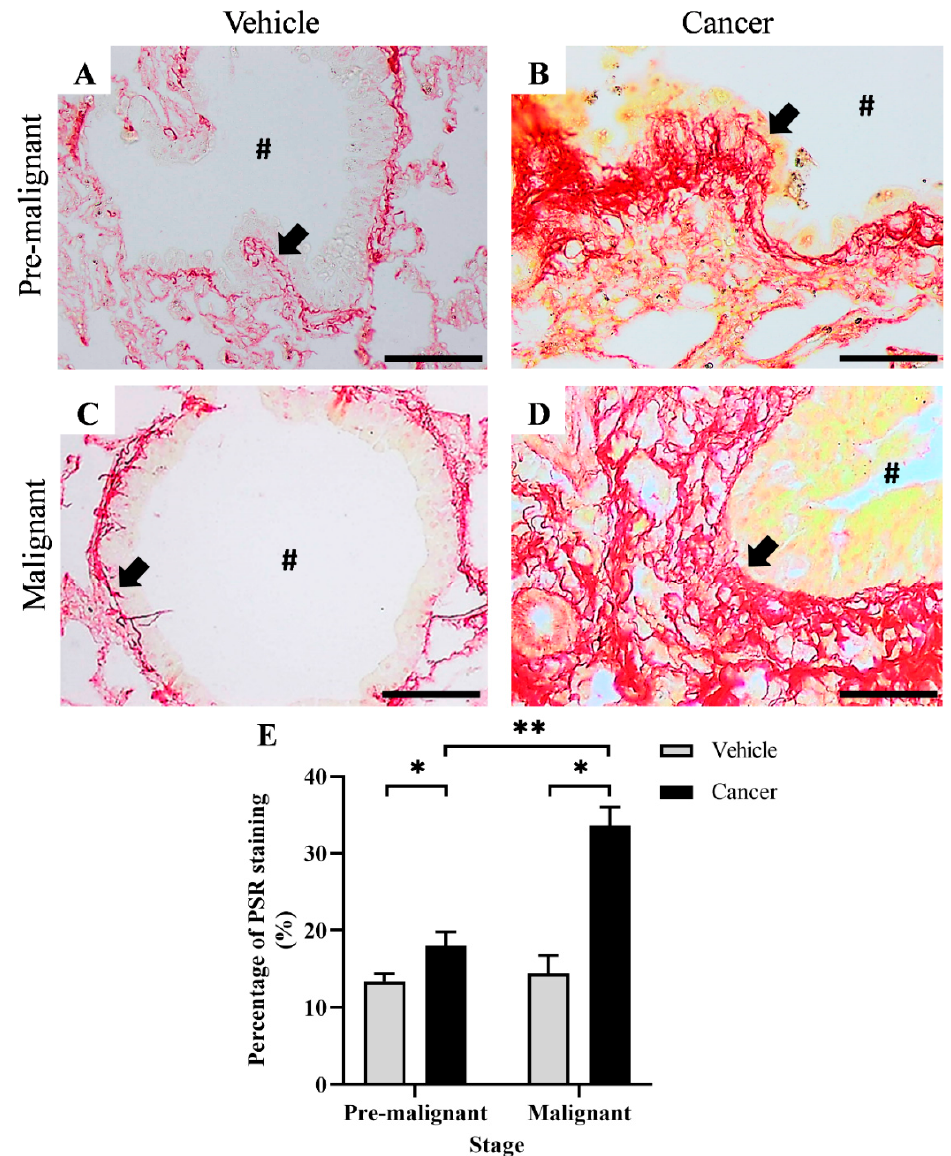
Figure 1. PSR staining at the bronchial area of the Vehicle and Cancer groups from both stages of carcinogenesis, at 40 × magnification. ( A , C ) showed PSR staining of normal bronchial with thin collagen fibrils, ( B ) showed PSR staining of pre-malignant lung SCC tissues with increased collagen fibrils. ( D ) showed PSR staining of malignant lung SCC tissues with an increased and thick layer of collagen fibrils. ( E ) showed the percentage of the PSR staining in the Vehicle and Cancer groups from both stages of carcinogenesis. Data are presented as mean ± SEM. Arrows pointed to the collagen. # is the airway lumen. Scale bars = 50 µm. * is a significant difference ( p < 0.05) between groups in the same stage. ** is a significant difference ( p < 0.05) between Cancer groups from different stages of carcinogenesis. p < 0.05 using Student’s t -test.